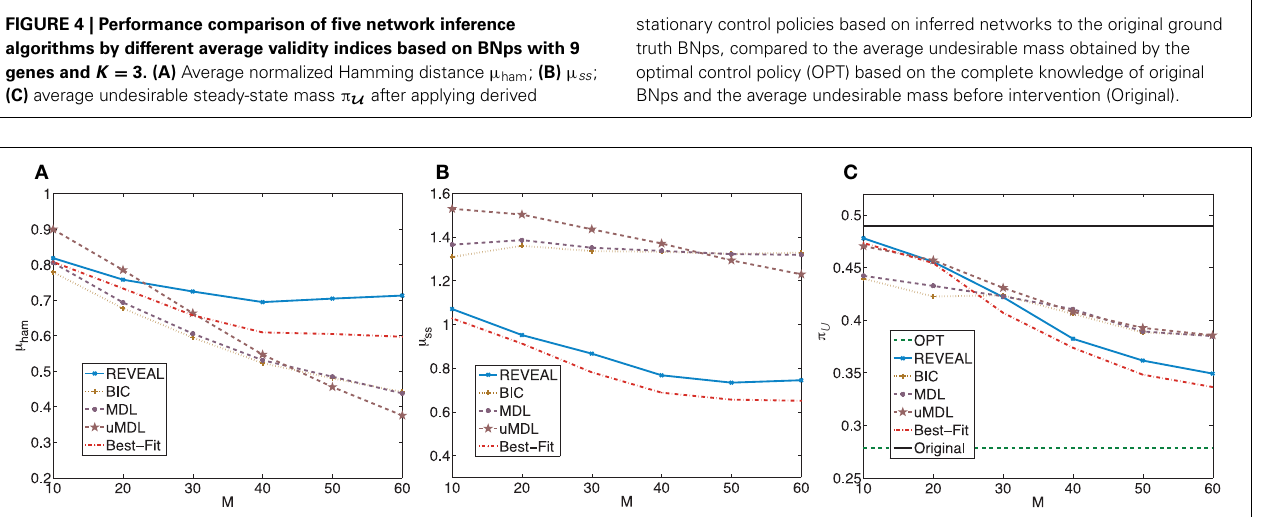
FIGURE 5 | Performance comparison of five network inference algorithms by different average validity indices based on BNps with 9 genes and K = 5. (A) Average normalized Hamming distance μ ham ; (B) μ ss ; (C) average undesirable steady-state mass π U after applying derived